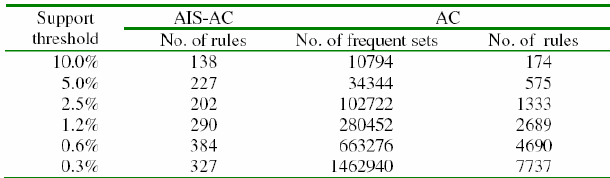
Table 1. Numbers of rules and frequent item sets for Adult data set